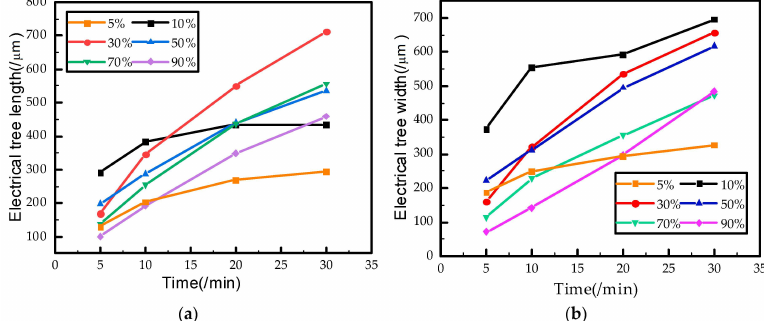
Figure 5. Electrical tree growth versus testing time under square wave voltage with di ff erent duty cycles. ( a ) Electrical tree length versus testing time and ( b ) Electrical tree width versus testing